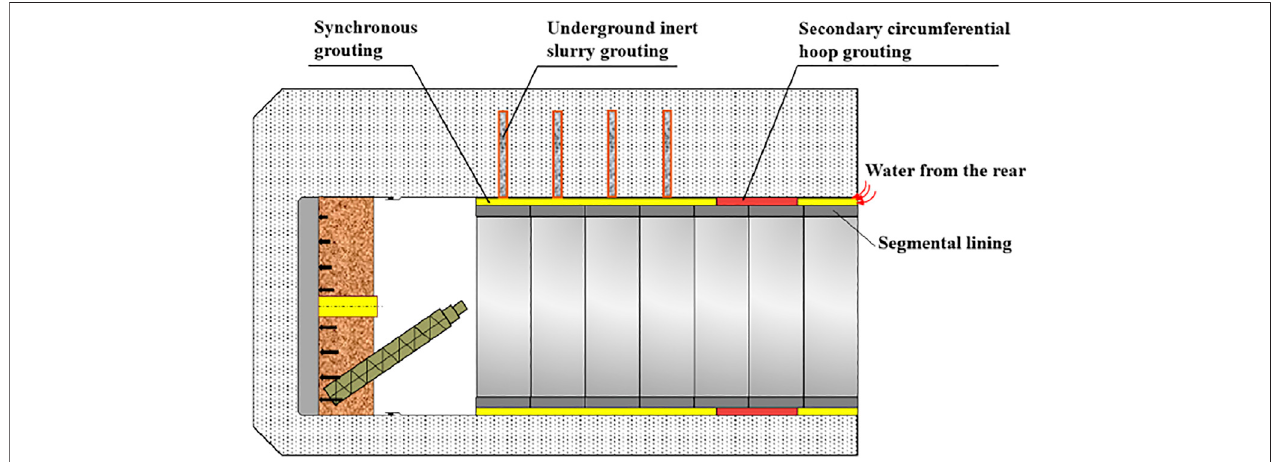
FIGURE 13 | Secondary circumferential hoop grouting at the shield tail to prevent water inrush.